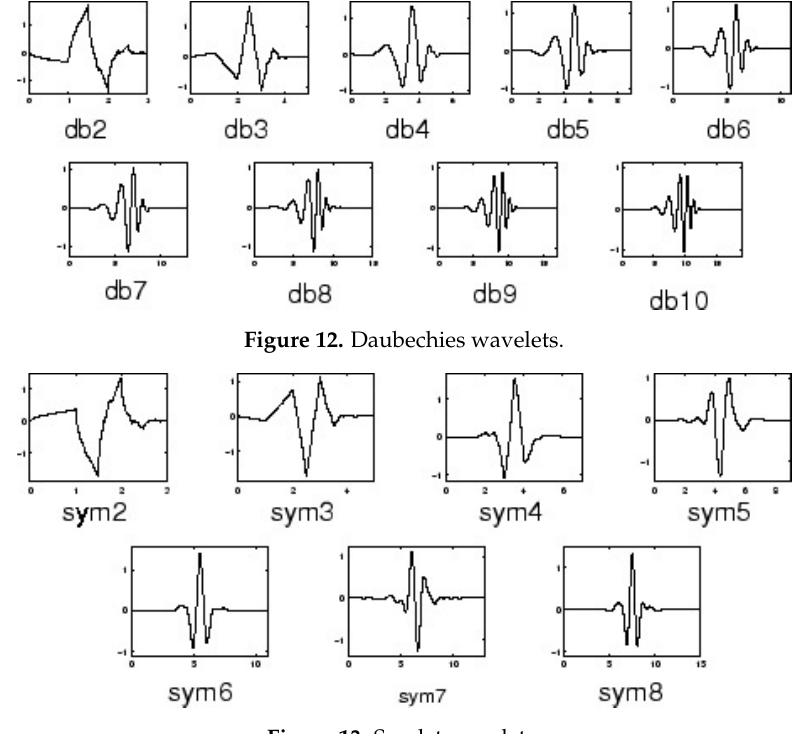
Figure 13. Symlet